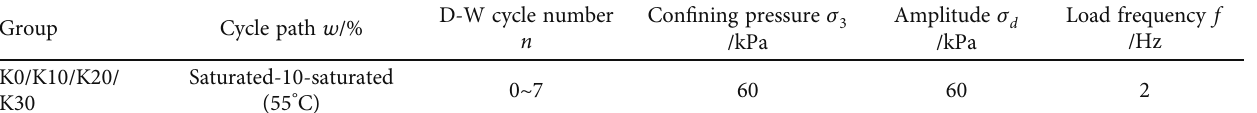
Table 2: Cyclic triaxial test conditions.